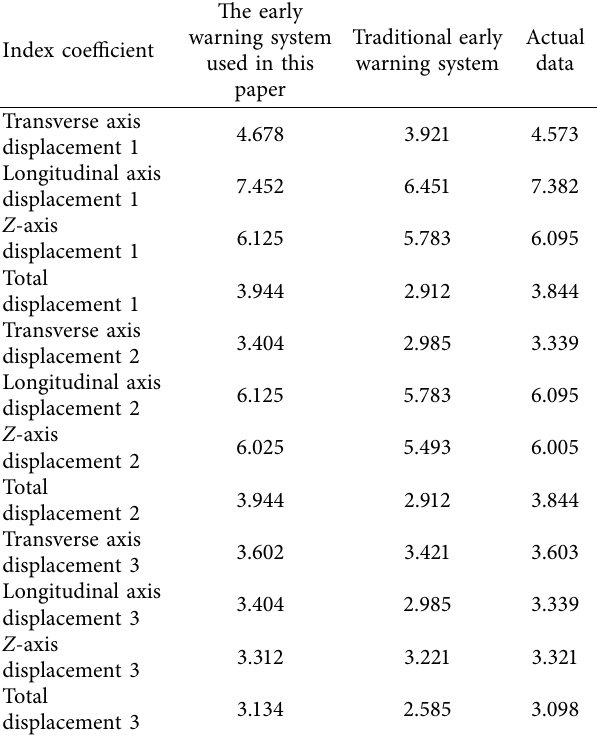
Table 7: Comparison of experimental data in area